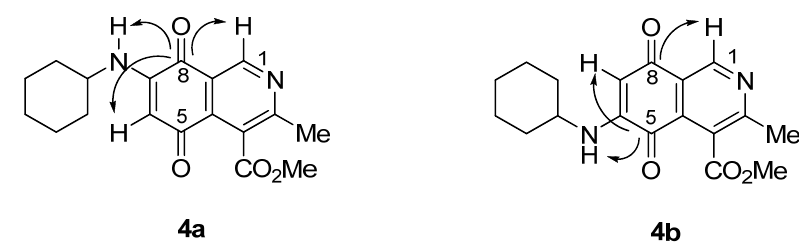
Figure 2. HMBC correlations of regioisomers 4a and 4b